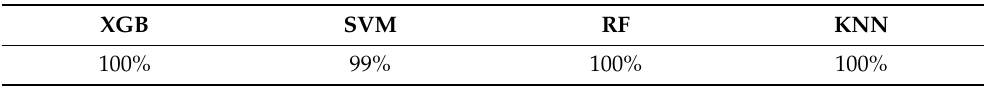
Table 4. Overall testing accuracy of different machine learning models for detection of hawkweed flowers at 0.65 cm/pixel.